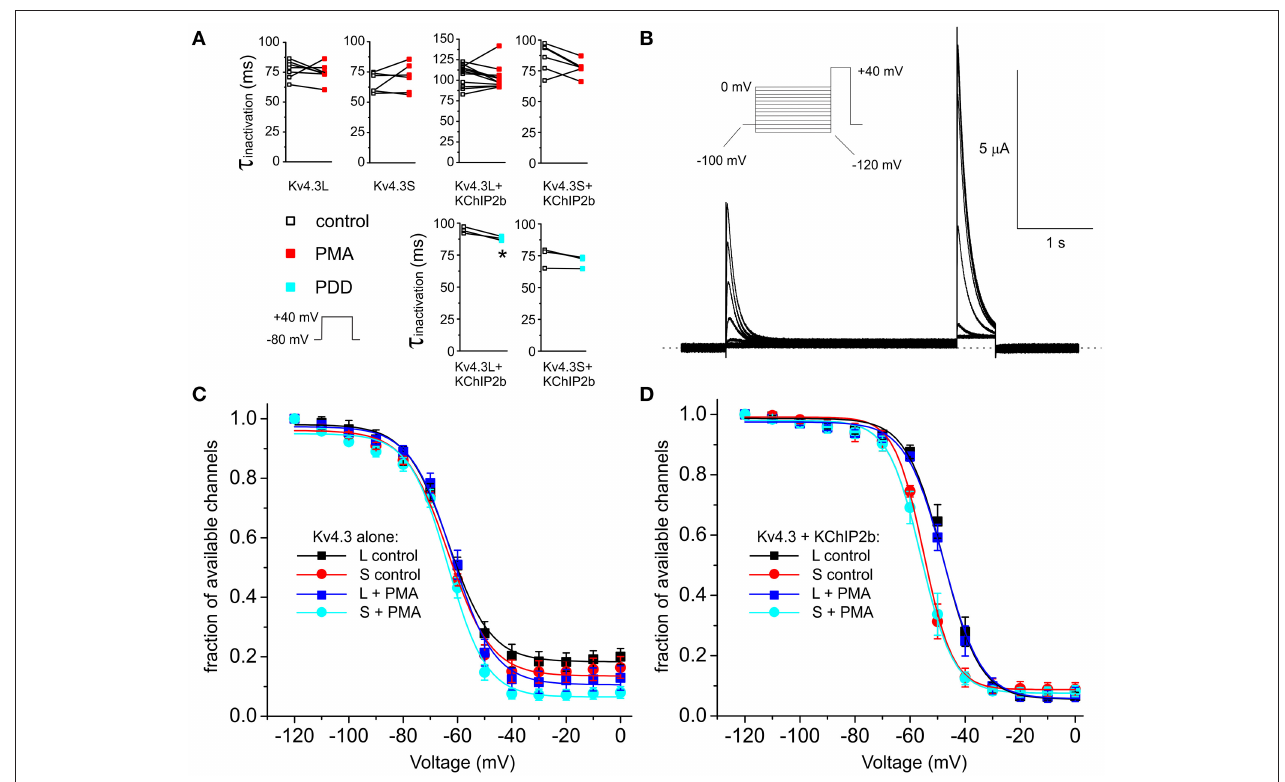
FIGURE 3 | PKC stimulation has no effects on Kv4.3 and Kv4.3-KChIP2b inactivation rate and voltage dependence. (A) Inactivation rates at + 40 mV ( τ of single exponential fit) for oocytes expressing Kv4.3L and Kv4.3S alone or with KChIP2b, before and after 15 min incubation with 50 nM PMA ( n = 6–12) or PDD ( n = 3). Upper inset: voltage protocol. * P < 0.05. (B) Exemplar current trace recorded from a Xenopus oocyte expressing Kv4.3L-KChIP2b using the steady-state inactivation protocol (upper left inset). Zero current level indicated by dashed line. (C) Mean ± SEM fraction of available channels/voltage relationship for Kv4.3L vs.